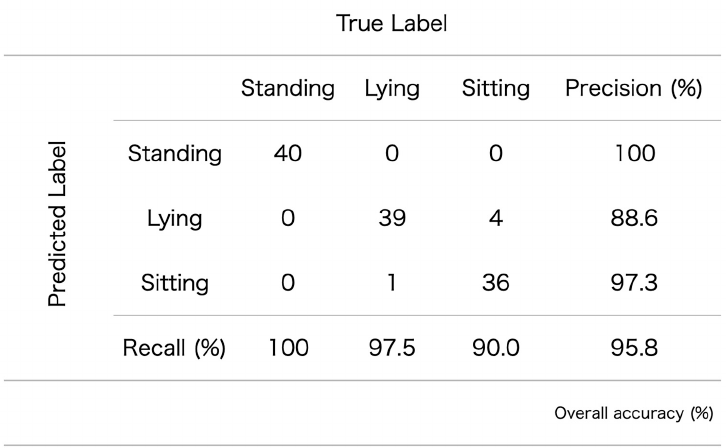
Figure 5. Confusion matrix of the overall test.